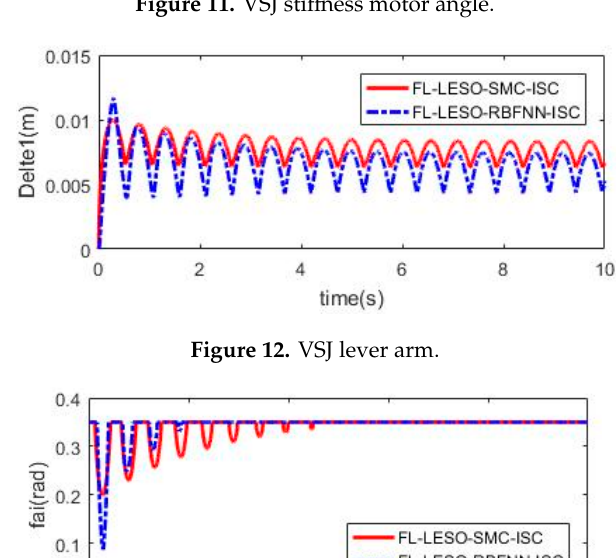
Figure 11. VSJ stiffness motor angle.